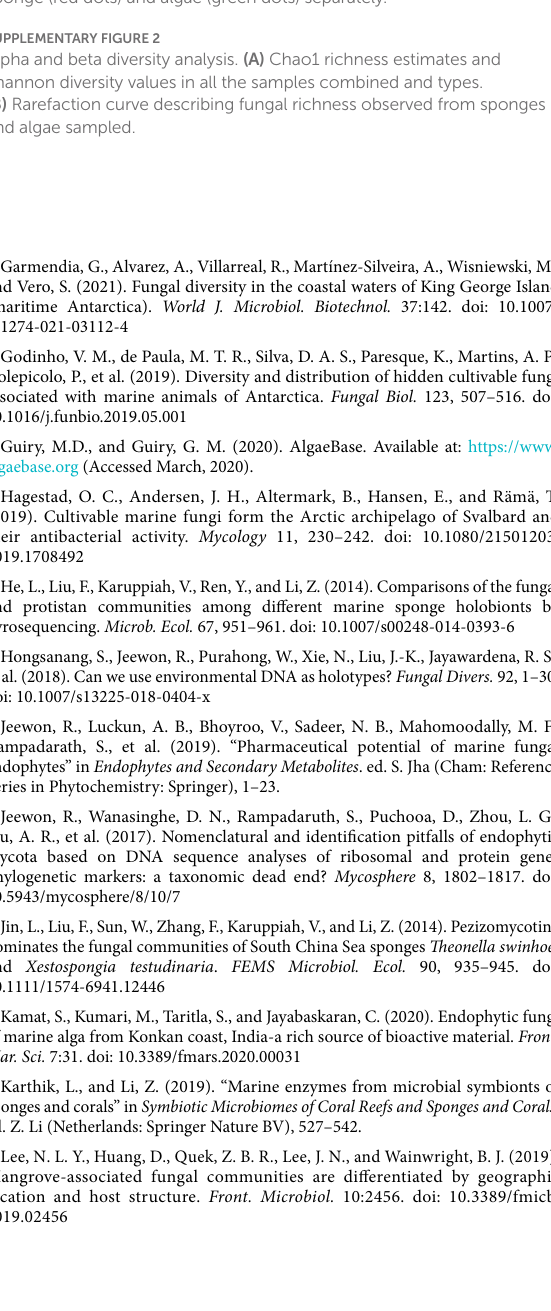
SUPPLEMENTARY FIGURE 1 Community composition. (A) Taxonomic summary at phylum level in all the samples. (B) Boxplot showing percentage of ITS gene copies recovered in all the samples. (C) Boxplot showing fungal diversity in sponge (red dots) and algae (green dots) separately. SUPPLEMENTARY FIGURE 2 Alpha and beta diversity analysis. (A) Chao1 richness estimates and Shannon diversity values in all the samples combined and types. (B) Rarefaction curve describing fungal richness observed from sponges and algae